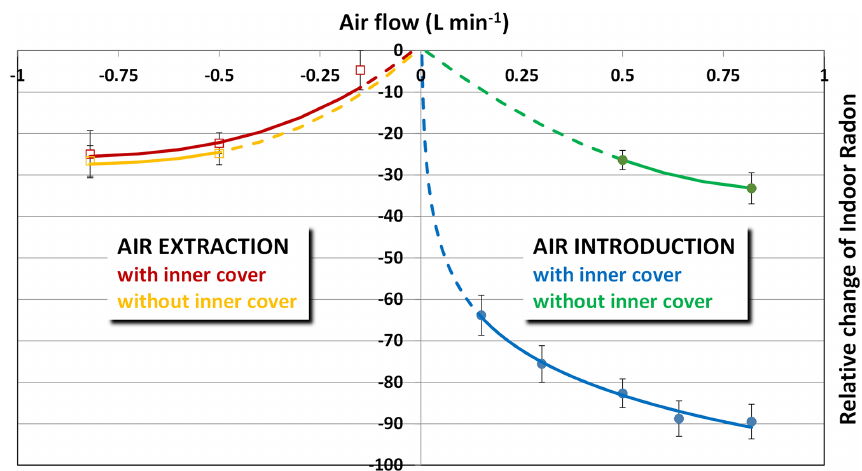
Figure 3. Relative change of Indoor 222Rn (RIR) at different air flows with or without a plasterboard coating the inner walls of the model room. RIR is equal to ( Rn air ventilation − Rn no ventilation )/( Rn no ventilation ) × 100. Green and blue curves on the right stand for RIR obtained in the “introduction of air” experiments of groups 1 (from test 1 to 5) and 3 (experiments 9 and 10); red and orange curves on the left side of the plot correspond to RIR recorded in the “extraction of air” experiments of groups 2 (from test 6 to 8) and 4 (experiments 11 and 12). Table 3. Parameters used in the modelling using the Fick’s second law (Eq. 3). Parameter Label Value Unity Radon diffusion coefficient a D 2 . 54 × 10 − 6 m 2 s − 1 Radon emanation factor b η 0.65 adimensional Density c ρ 2310 kgm − 3 226 Ra specific activity c a 190 Bqkg − 1 222 Rn decay constant λ 2 . 09794 × 10 − 6 s − 1 Porosity c p 0.43